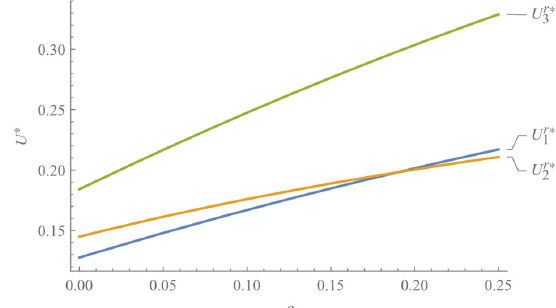
Fig. 4. The impact of the manufacturer's risk aversion on the retailer’s